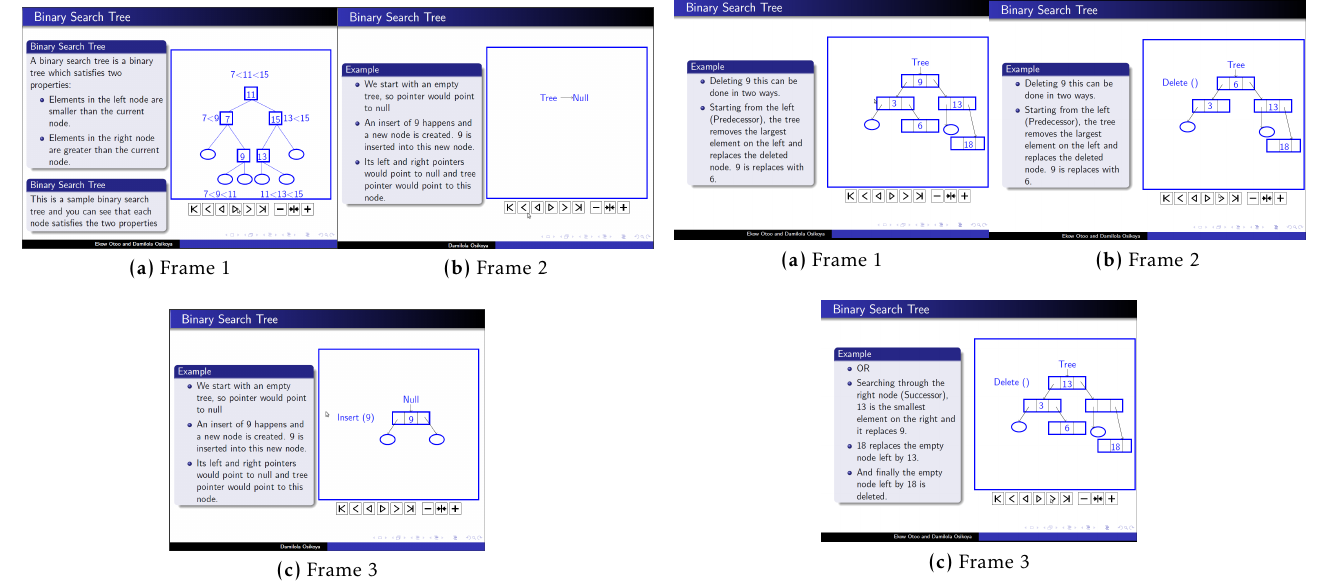
Figure 12. (Insert Operations in a Binary Tree) To replace element 9 from the right (Successor), 13 which is the smallest element on the right replaces